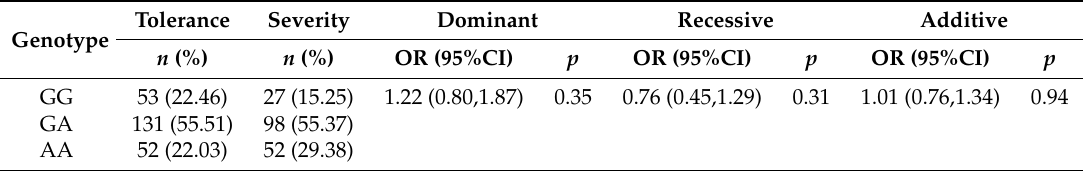
Table 9. Association between CASC8 rs10505477 and overall severe toxicity induced by platinum-based chemotherapy in lung cancers.